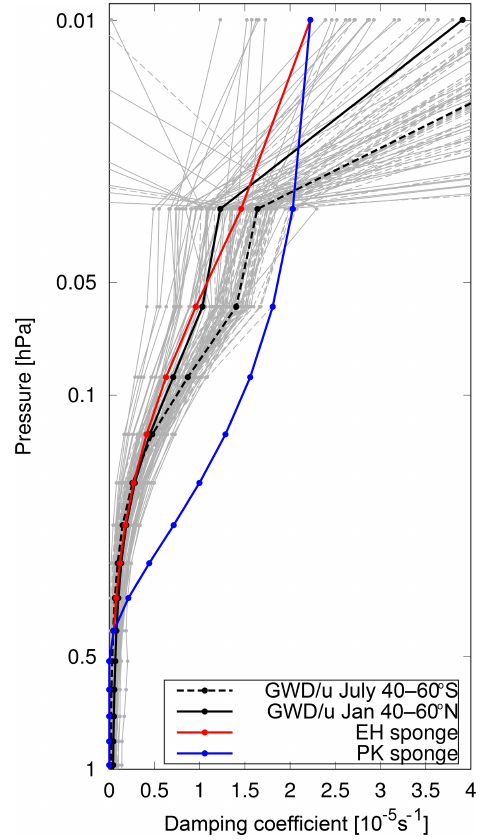
Figure 6. Damping coefficient (s − 1 ) of the sponge layer in the EH (red) and in the PK02 setup (blue) together with the effective damping timescale of the zonal winds by gravity wave drag (i.e., − GWD/u) from an ECHAM simulation with a non-orographic and orographic GW scheme, averaged over 40–60 ◦ S from July 1960 to 2010 (dashed gray line; average over all years shown as a dashed black line) and averaged over 40–60 ◦ N from January 1960 to 2010 (solid gray line; average over all years shown as a solid black